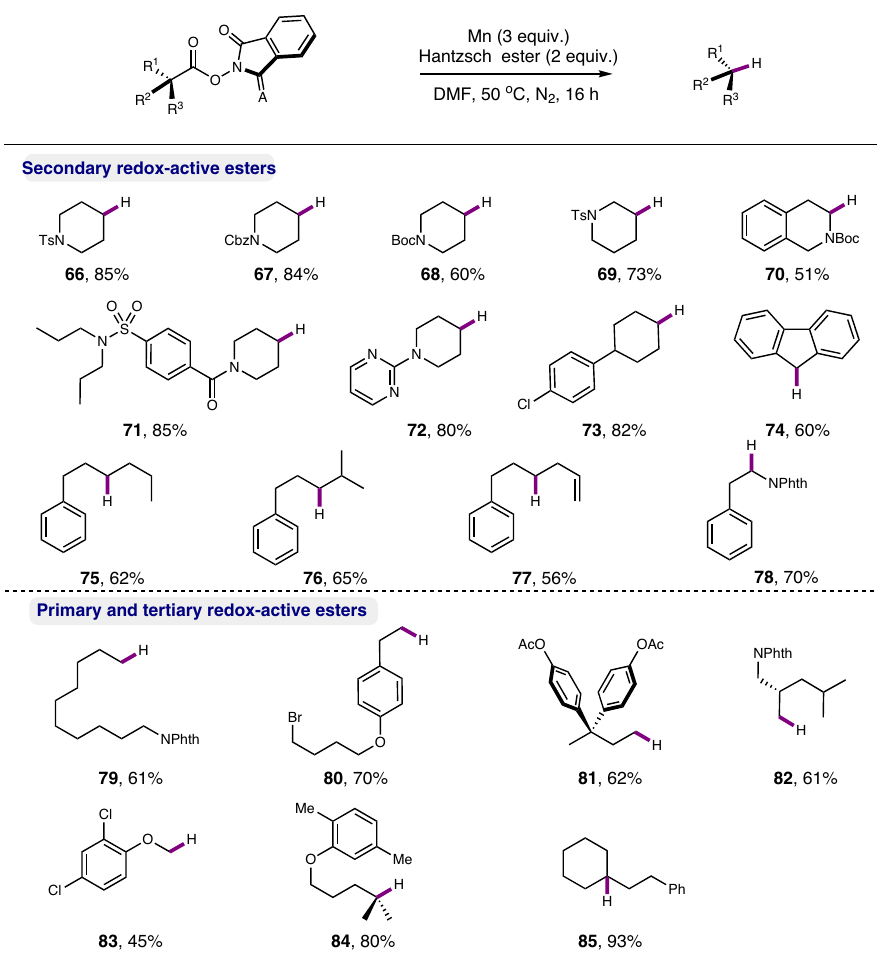
Fig. 6 Scope of decarboxylative hydrogenation. Reaction conditions: NHPI ester (0.2 mmol), Hantzsch ester (0.4 mmol), Mn (0.6 mmol), in DMF (0.4 M), 50 °C, N 2 , 16 h; yields are for isolated